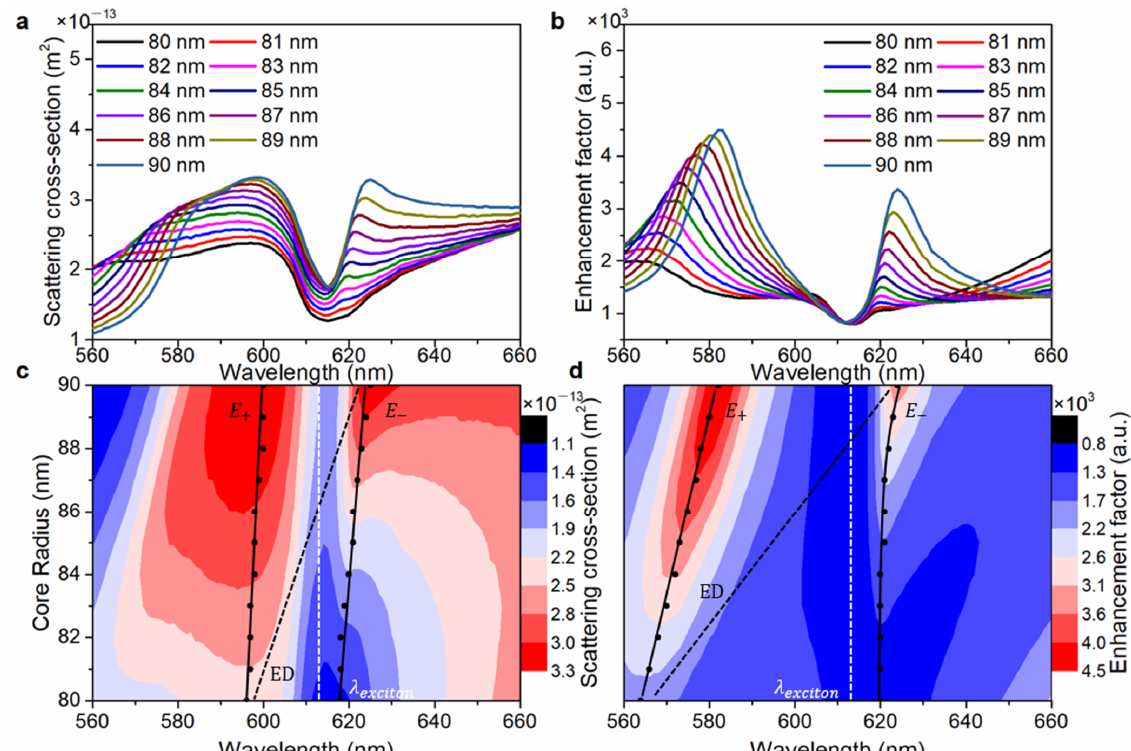
Figure 3. ( a ) Simulated scattering cross-section curves of system-1 with the different silicon radii. ( b ) Simulated enhancement factor intensity curves of system-1 with the different silicon radii. ( c ) Simulated scattering cross-section map of system-1 varying with wavelength and core radius. ( d ) Simulated enhancement factor intensity map of system-1 varying with wavelength and core radius.